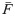
Relationships between plant diversity and natural resource diversity.Effect of species richness and phylodiversity on FT (a,b), F¯ (c,d), and D (e,f). Non-overlapping letters signify significant difference at α ≤ 0.05.